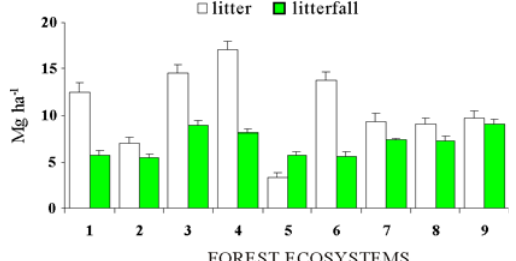
Figure 4. Total litterfall and litter layer nutrient (Figure 5). Leaves accounted for over 90 % of the litter layer mass in all forest ecosystems (data not shown).